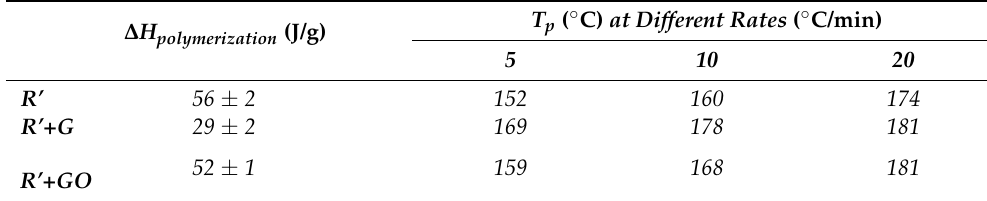
Table 7. Polymerization enthalpy and curing peak of R’ and